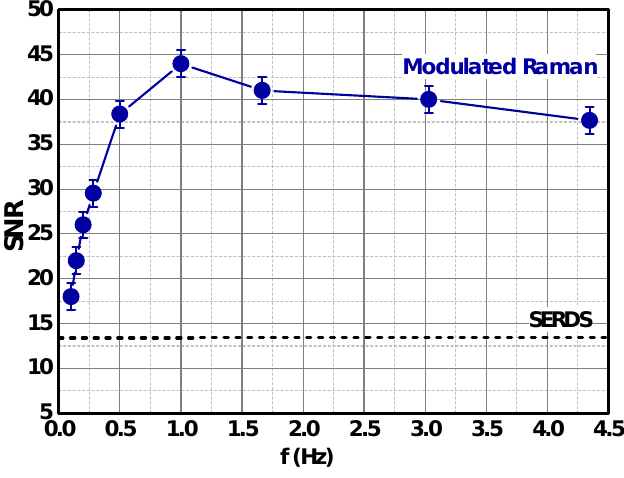
Figure 5. Signal-to-noise ratio (SNR) of the polystyrene Raman peak at 1001 cm − 1 as a function of the laser wavenumber modulation rate ( f ) for modulated Raman spectra. The SNR measured by using the SERDS approach is additionally shown (dashed